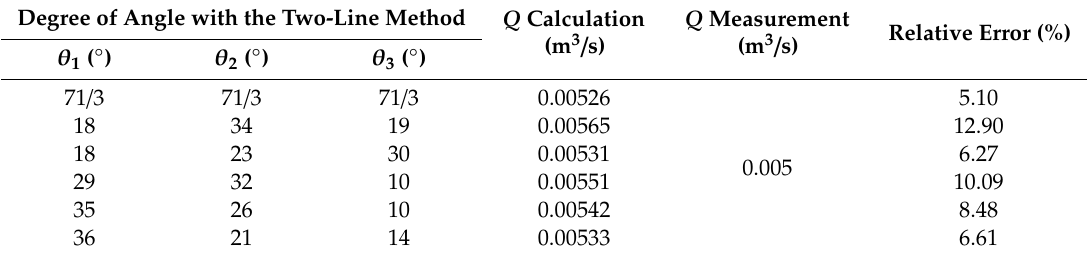
Table 3. Analysis of calculated and measured discharge under di ff erent combinations of angles (S1). Degree of Angle with the Two-Line Method Q